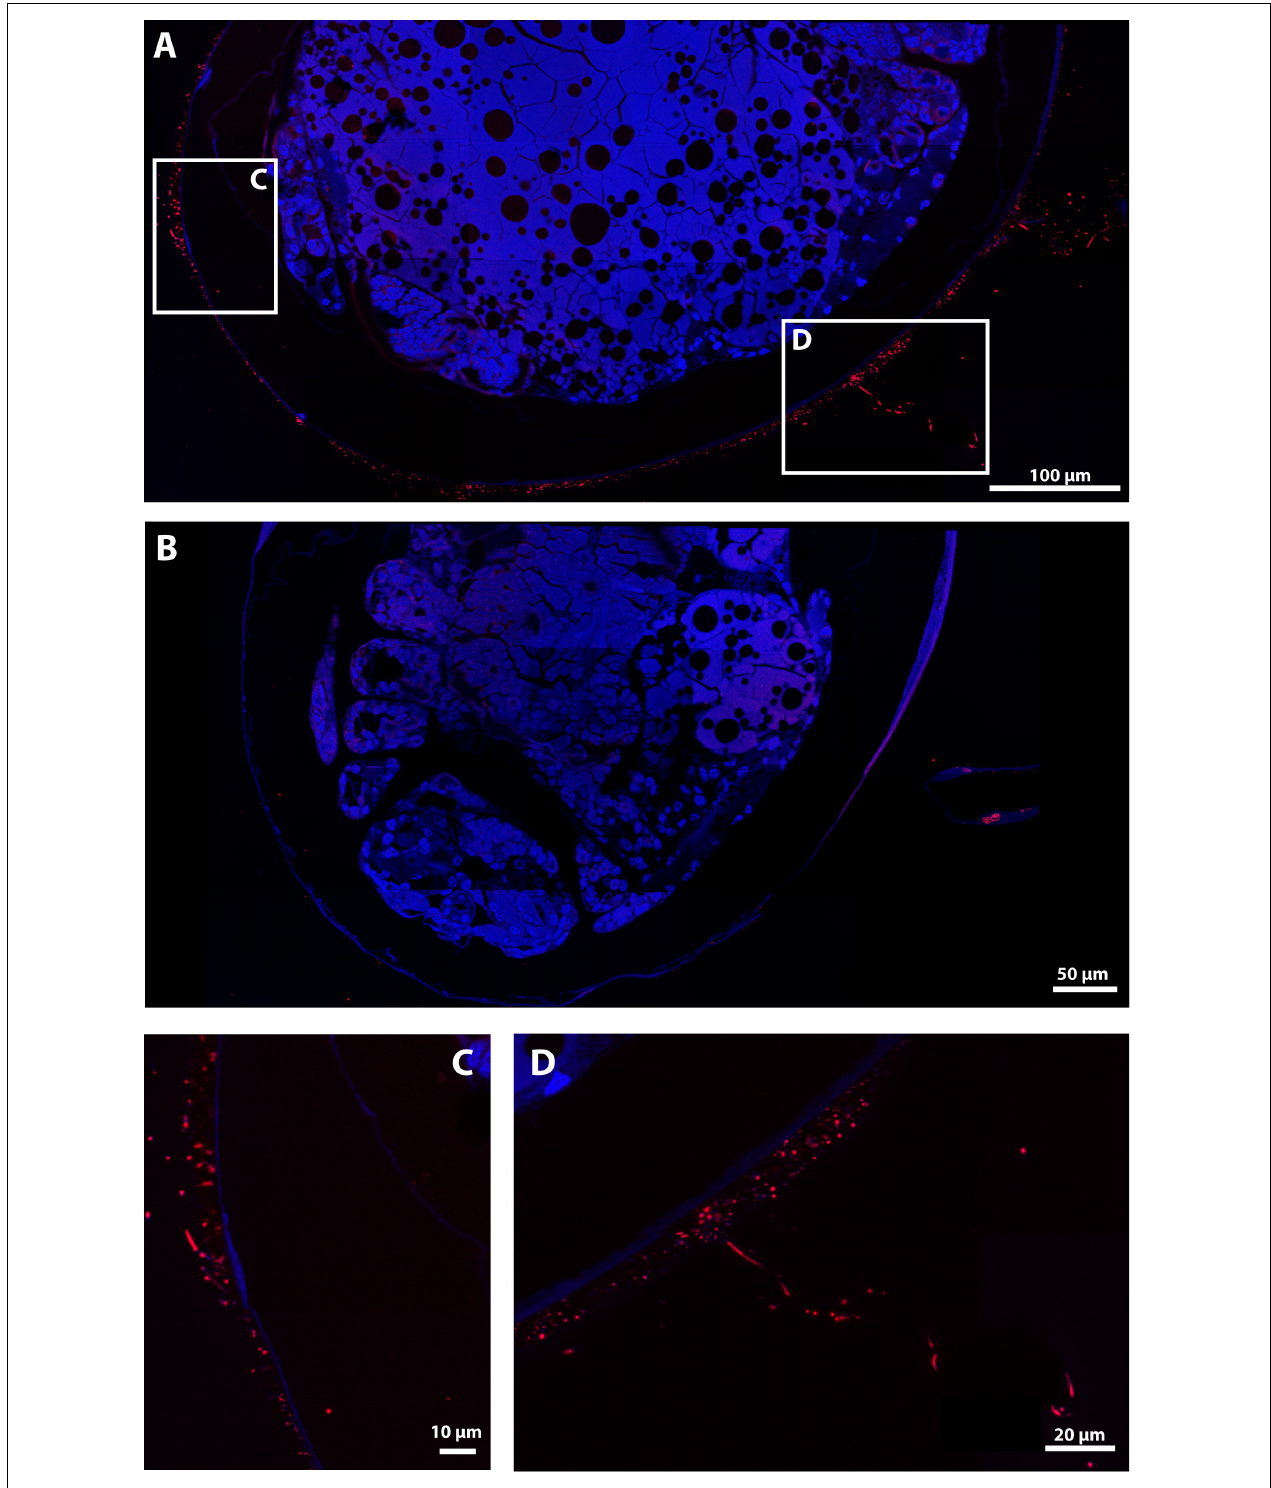
FIGURE 7 | FISH Observations of Rimicaris exoculata late stage eggs with universal bacteria probes. Observations were performed on semi-thin sections (2 µ m) stained with DAPI (blue) and hybridized with Eub338-Cy5. (A,C,D) Egg from the external part of the brood with abundant mineral deposits, (B) Egg from the internal part of the brood without mineral deposits, Colors = Red ( Eubacteria